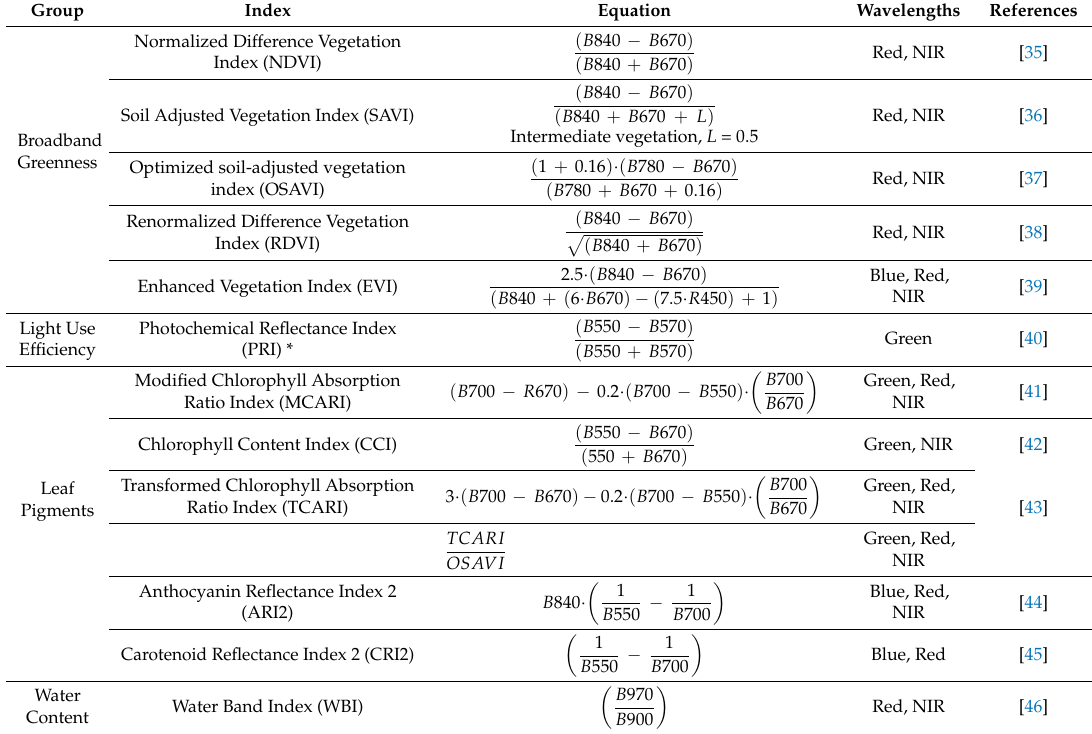
Table 1. Indexes derived from the multispectral visible and near infrared bands. The wavelengths used in the formulation of the indexes are adapted slightly based on the multispectral micro-MCA Tetracam camera. * Note that for the PRI index, B550 is used instead of the original B531 by the cited reference